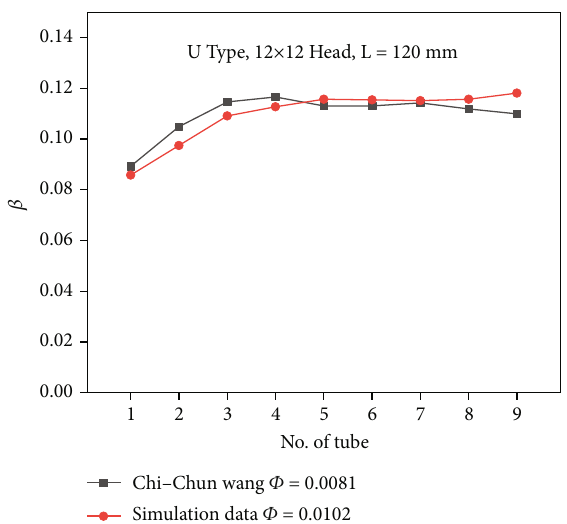
Figure 4: Nonuniformity coe ffi cient with di ff erent AR values.